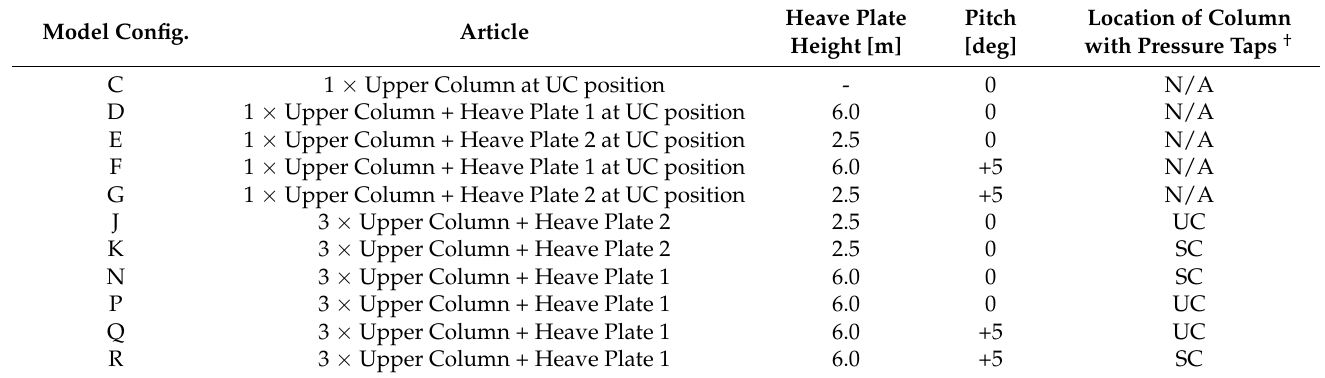
Table 1. Model configurations examined in OC6 Phase